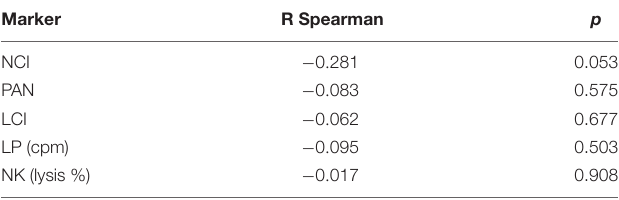
TABLE 4 | Stress and immune marker correlations.